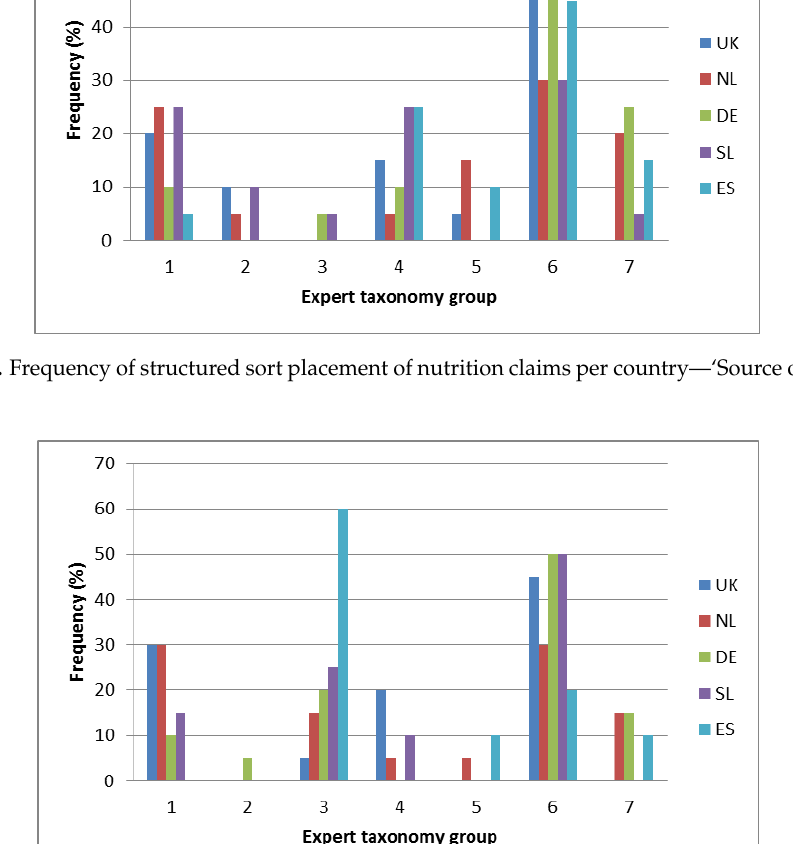
Figure A6. Frequency of structured sort placement of nutrition claims per country—‘Contains wholegrain’ (Card 23).